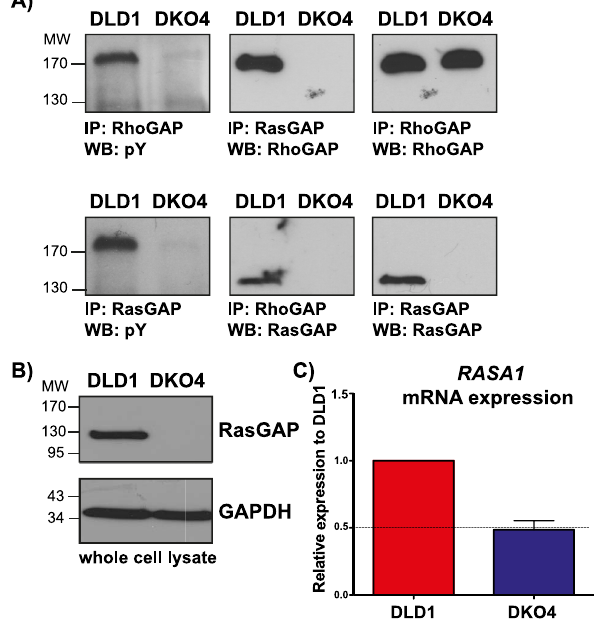
Figure 1. RhoGAP phosphorylation and RasGAP expression in DLD1 and DKO4 cell lines. A) RhoGAP and RasGAP were immunoprecipitated from DLD1 and DKO4 cells. Immunoprecipitates were subjected to Western blotting and probed for total phosphotyr- osine, RasGAP and RhoGAP. Western Blotting of whole cell lysates (A) and rt-QPCR (C) were used to determine total protein and mRNA levels respectively in these cell lines.